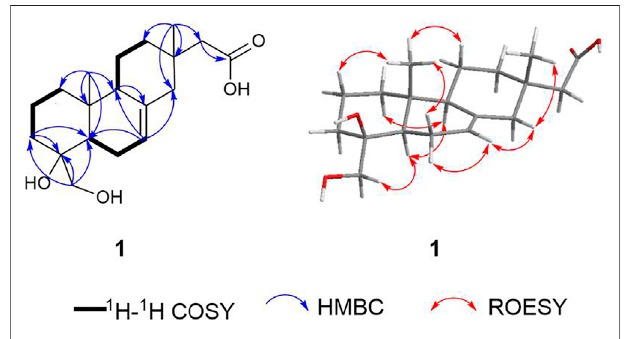
FIGURE 2 | Key 2D NMR correlations of compound 1 .